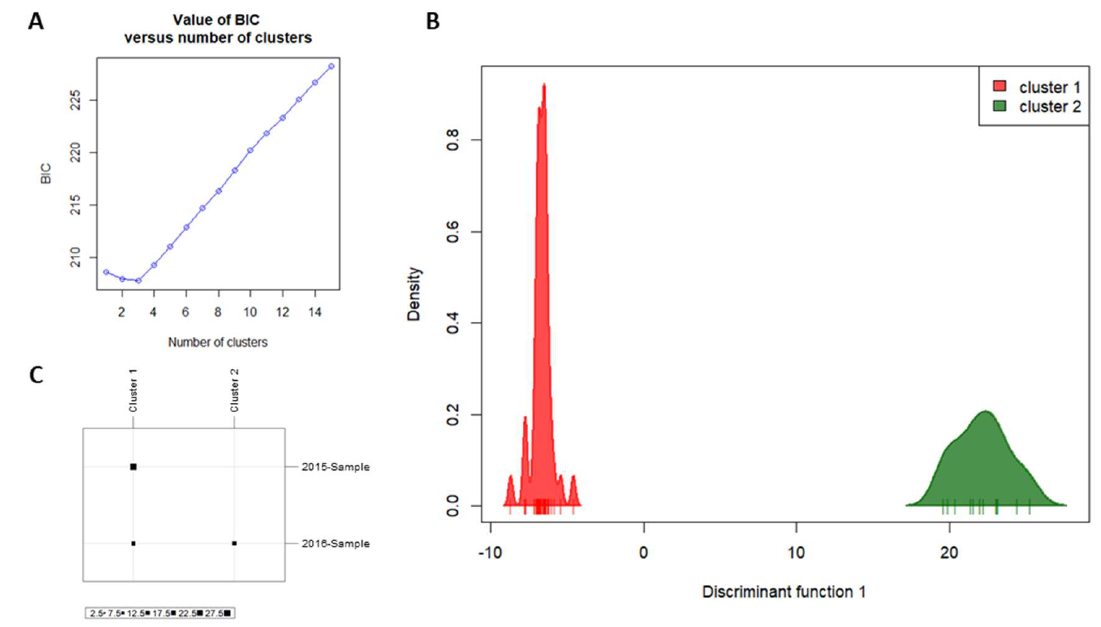
Figure 2. Discriminant analysis of principal components (DAPC) results based on SNP data. ( A ) Graph of Bayesian information criterion (BIC) values versus number of clusters. The lowest BIC value indicates K = 3 as the optimal number of clusters. However, we considered K = 2 as the best option to explain the distribution of variation in temporal samples of New World screwworm (NWS) flies; ( B ) density plot of the two clusters; ( C ) graph indicating the population of origin of the individuals from each cluster. Cluster 1 is composed of 27 individuals from 2015-Sample and 13 individuals from 2016-Sample, while cluster 2 has only individuals from 2016-Sample (12 individuals).